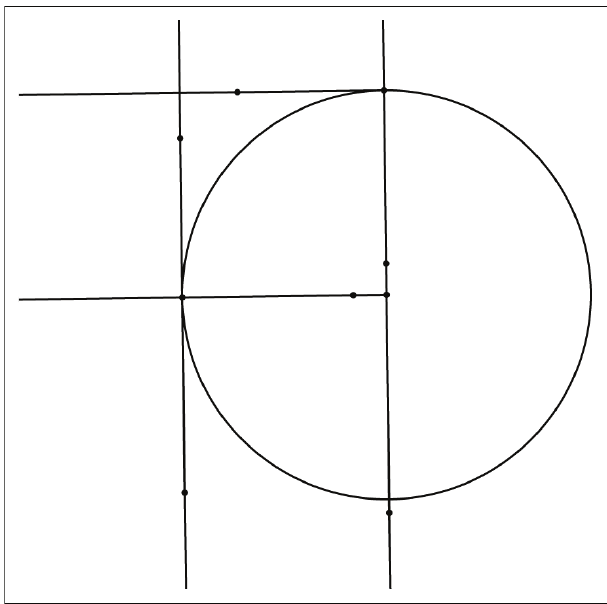
FIGURE 3: Attempt at the construction of a square as illustrated in the